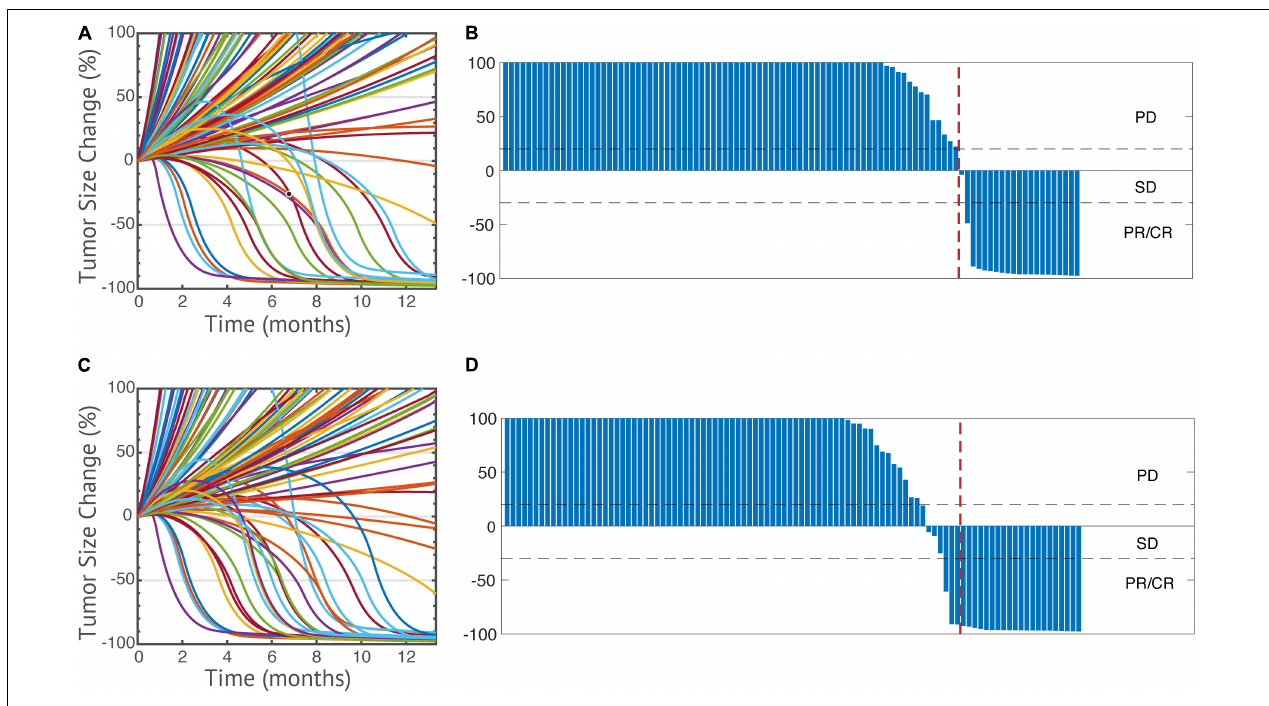
FIGURE 3 | Spider plots of 100 randomly selected virtual patients (A,C) and change from baseline in model-predicted tumor diameter assessed by RECIST v1.1 (B,D) in anti-PD-1 monotherapy (A,B) and its combination with entinostat (C,D) . PD, progressive disease; SD, stable disease; PR, partial response; CR, complete